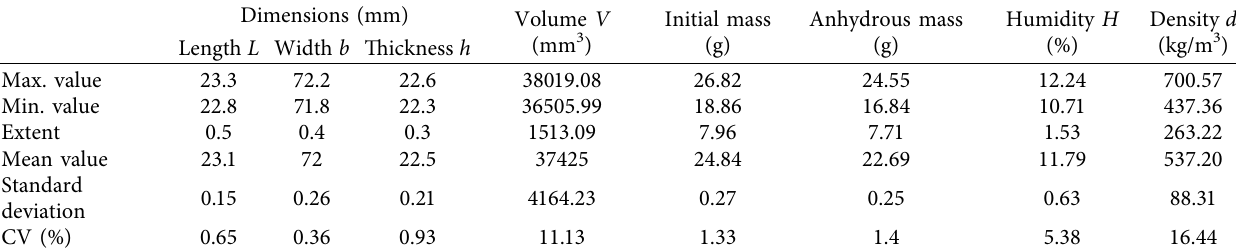
Table 1: Summary of the physical properties of the local wood Terminalia Superba (Frak´e). Dimensions